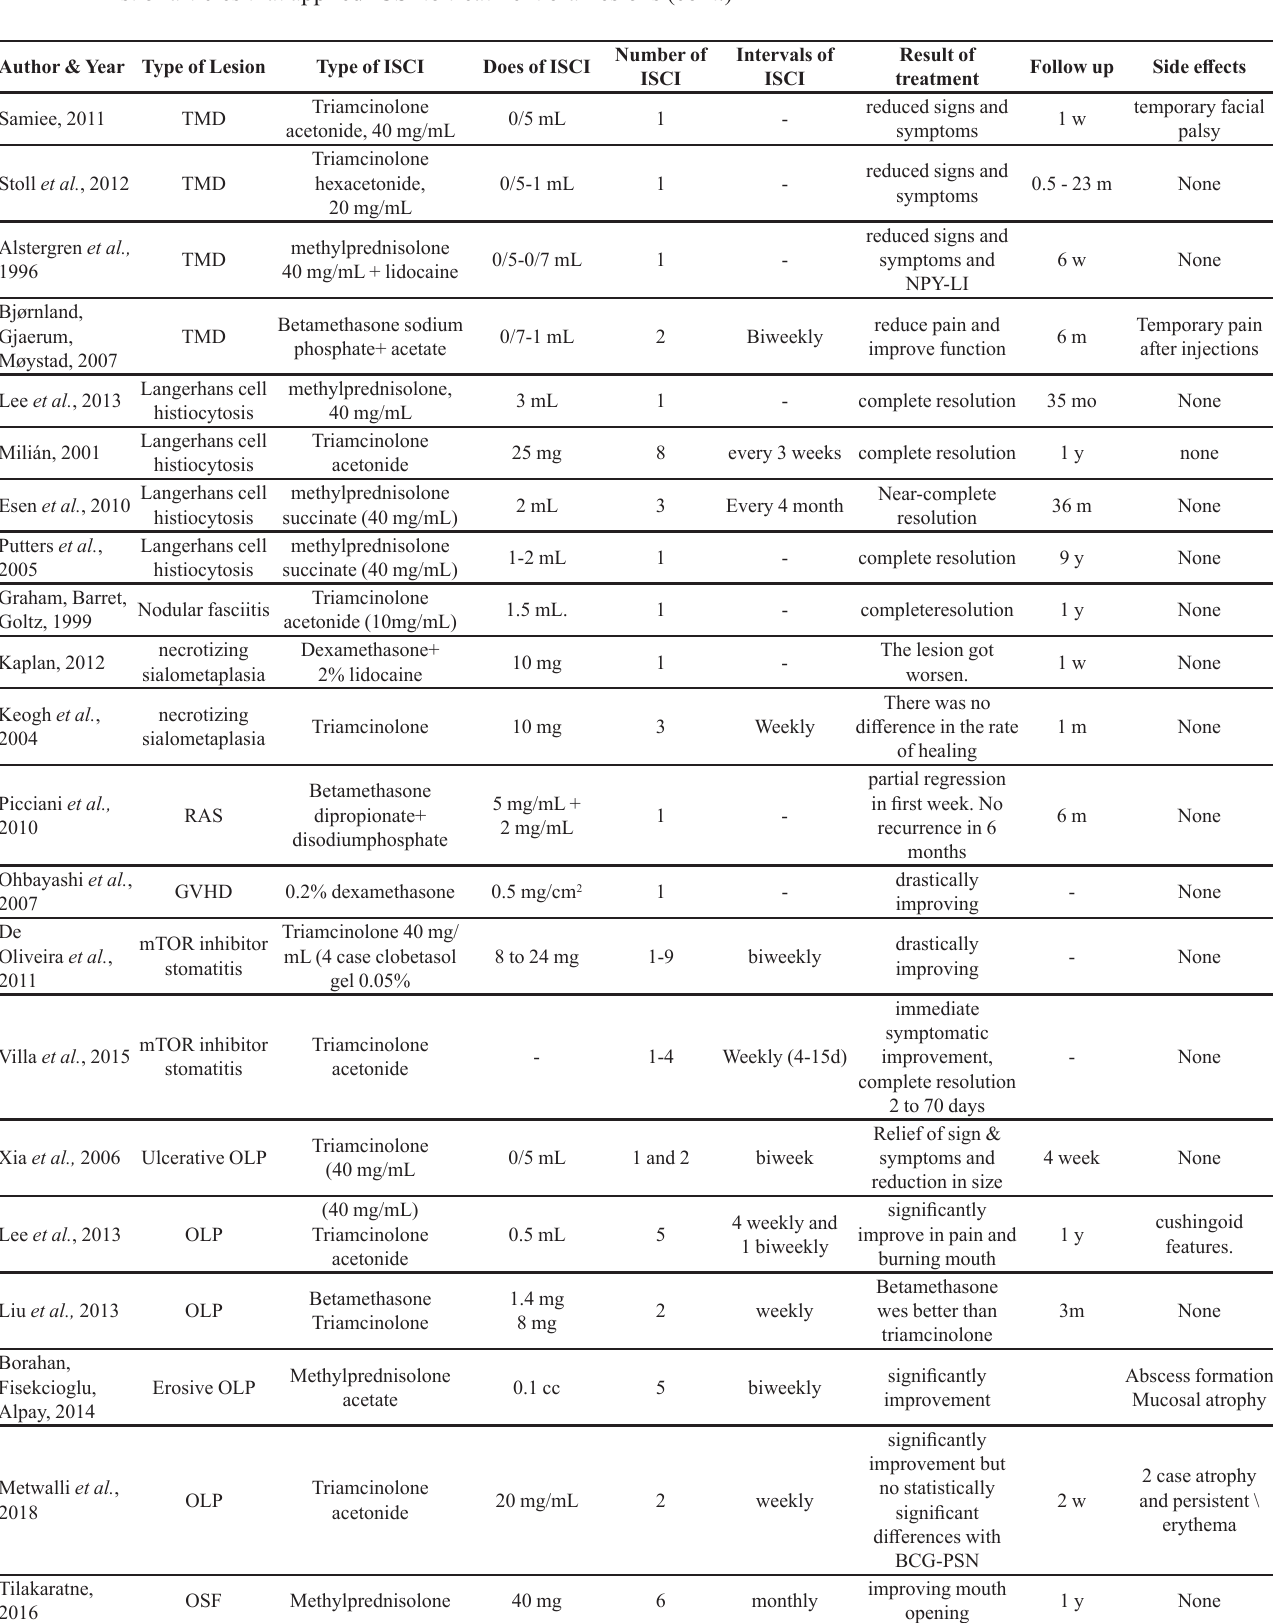
TABLE I - List of articles that applied ICSI to treatment oral lesions